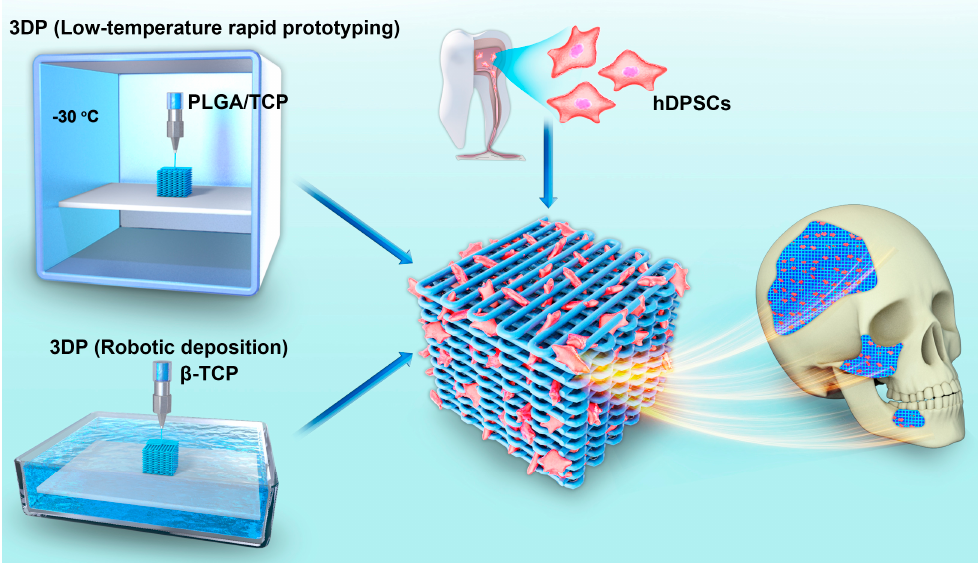
Figure 1. Overview of the application of two types of 3DP technologies used to fabricate sca ff old incorporated with hDPSCs for oral and maxillofacial bone reconstruction.